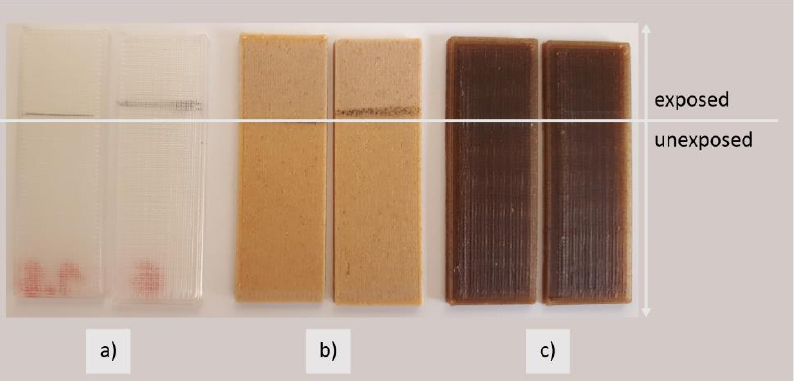
Figure 11. Samples after exposure to Xe light; bottom: unexposed part, top: part exposed to Xe light; ( a ) PLA_3D, ( b ) PLA-Woodfill_3D, and ( c ) PLA- Entwined_3D.